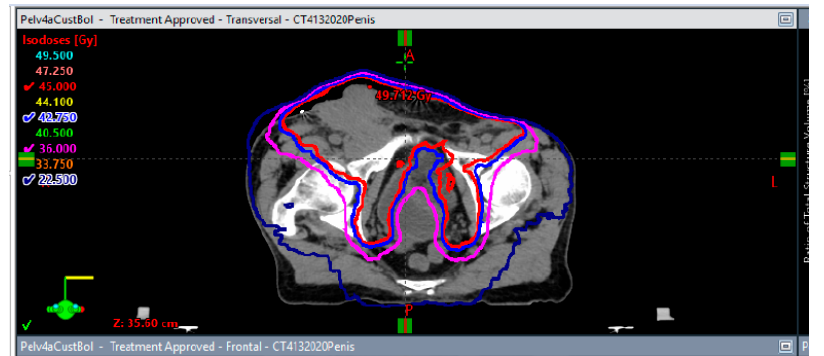
Figure 3. CT scan images from baseline ( A ) and post treatment ( B ). Time points represent significant decrease in size and enhancement in confluent retrocaval and aortocaval lymphadenopathy (arrow- heads) with mass effect on the inferior vena cava (IVC) at baseline.